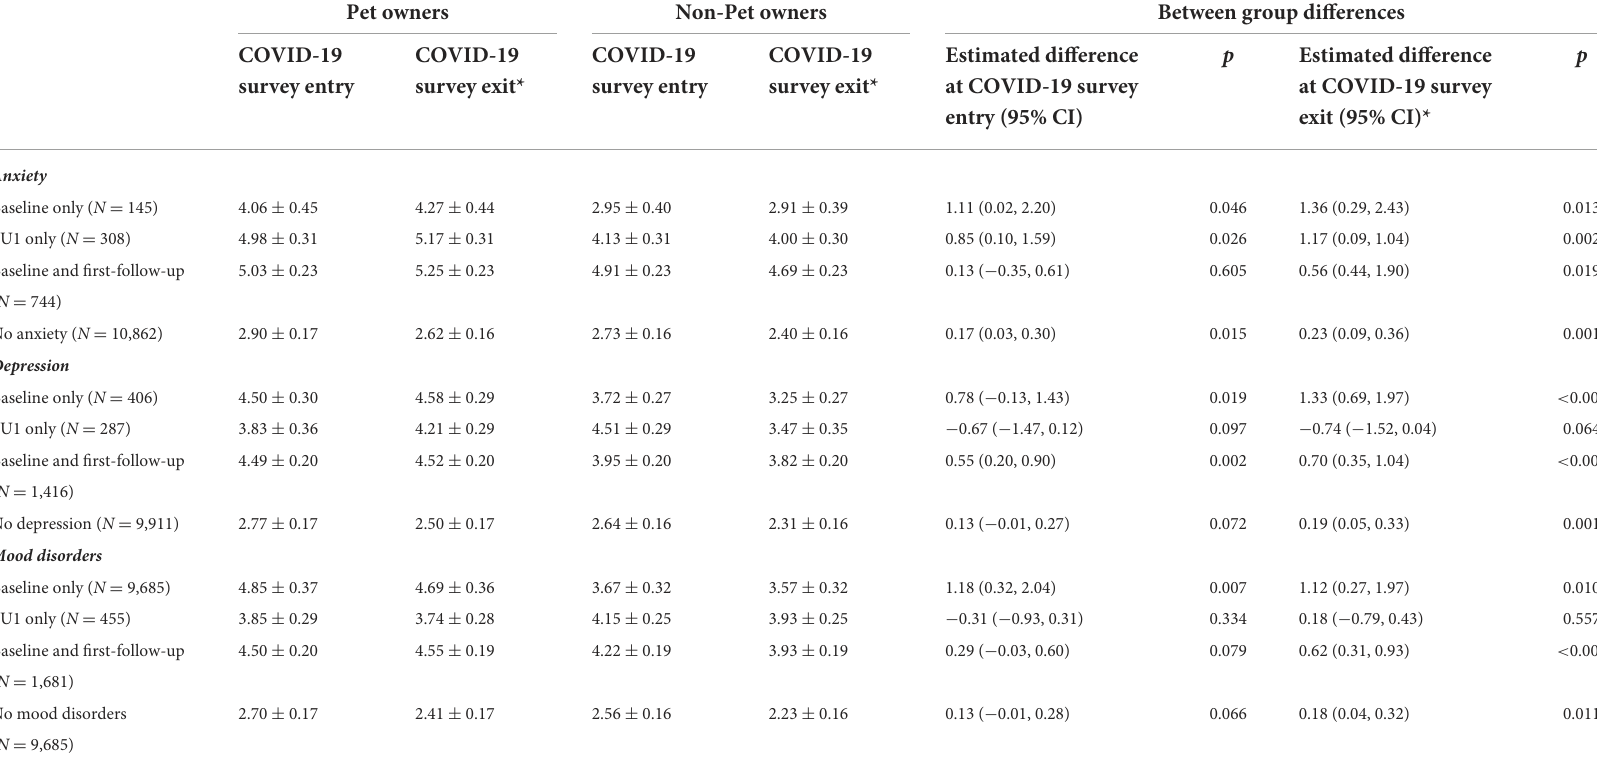
TABLE 7 Estimated marginal means and standard errors for changes in General Anxiety Disorder Questionnaire (GAD-7) score at COVID-19 Survey entry and exit based on changes in mental health disorder status from baseline (i.e., 2010–2015) to FU1 (2015–2018) and pet ownership at